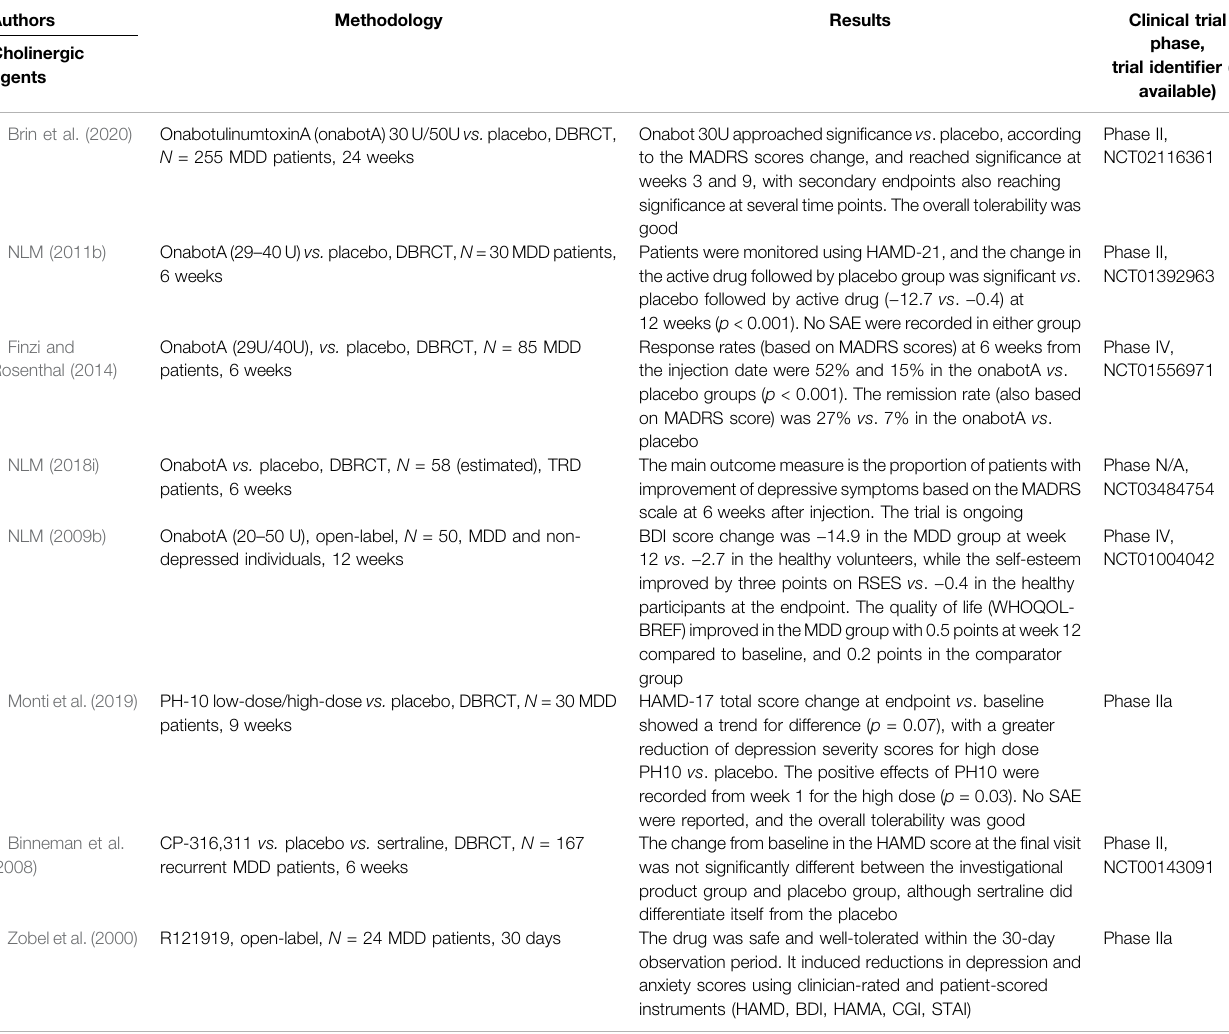
OnabotulinumtoxinA(onabotA)30U/50U vs. placebo,DBRCT, N = 255 MDD patients, 24 weeks